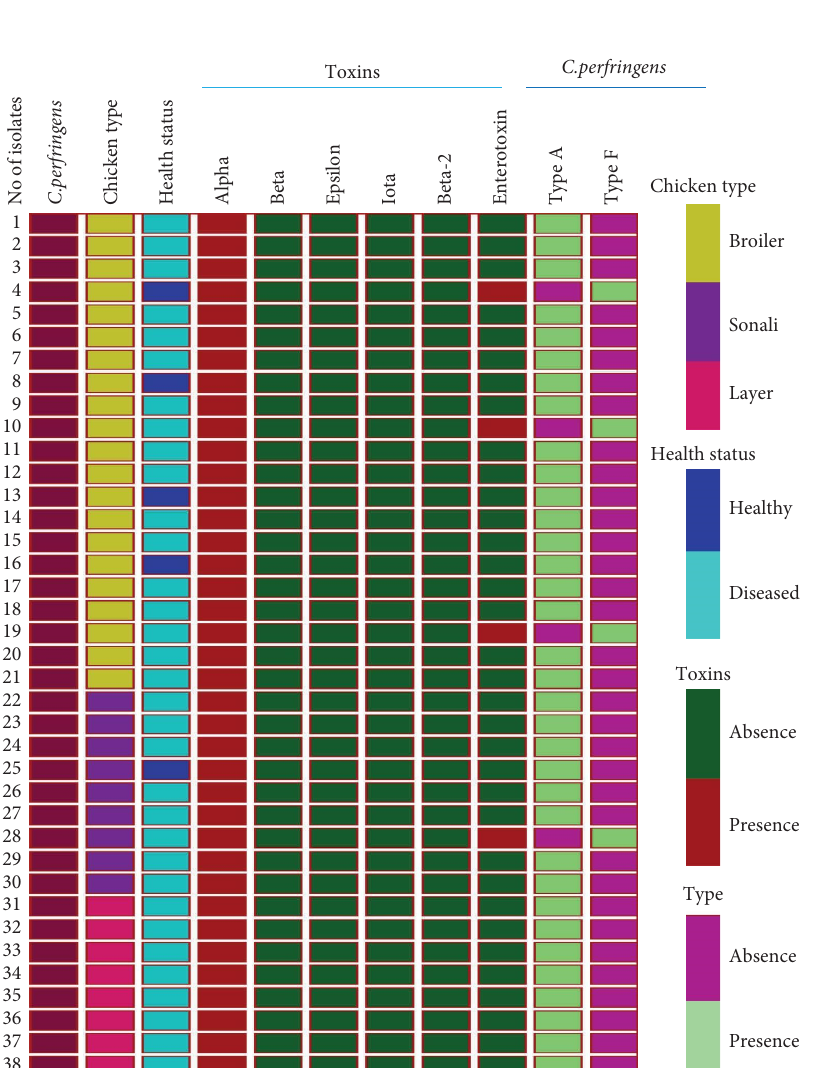
Figure 2: Heat map illustrates the chicken types and their health status as well as the distribution of diferent C. perfringens types and their